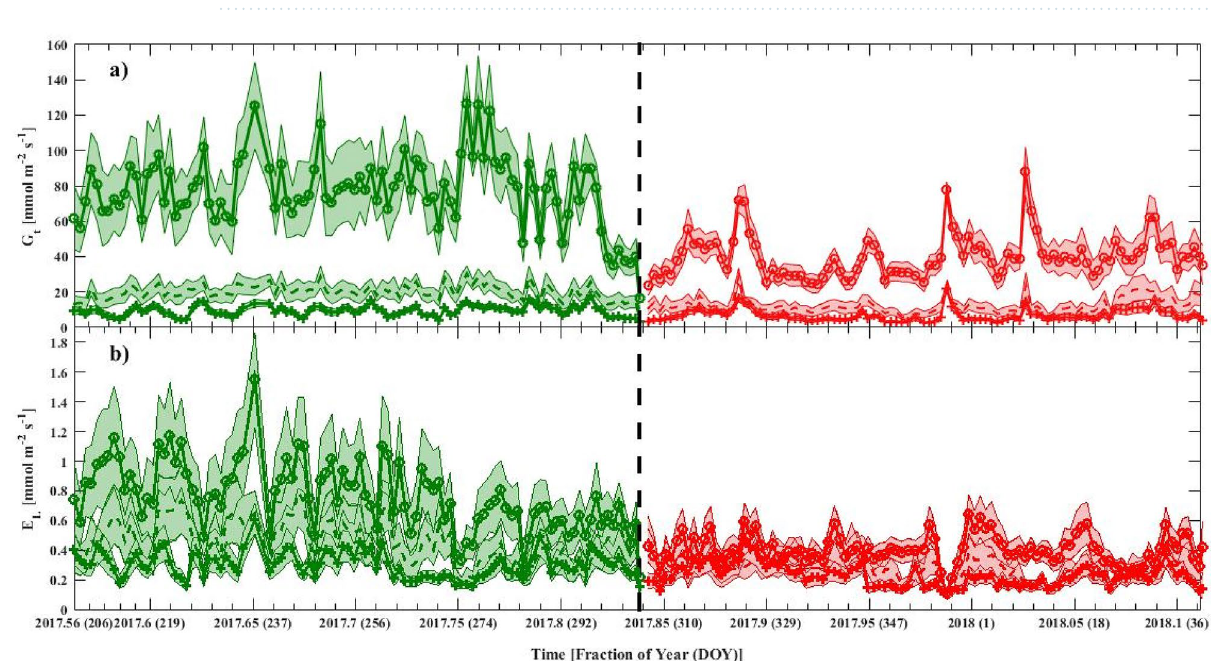
indicated in Table 2, whole-tree canopy conductance varied the greatest in L. speciosa with the relative sensitivity to natural log of VPD being low (λ/ G ref < 0.50) during both seasons for all the species, with only exception being P. indicus during the dry season (λ/ G ref > 0.70). Both G t and E L showed similar seasonal variation for a given species but with varying intensity (Fig. 2). The uncertainty in daily G t and E L averages was high during the wet season, indicating that the variability in VPD and soil moisture contributed greatly, relative to the model error. Such errors can be amplified further at much shorter, half-hourly timescale, as indicated by the variable R 2 for the three species (Fig. 1). Overall, the mean values of both G t and E L were statistically different among species and between seasons. L. speciosa had the highest G t and E L while P. indicus had the lowest values. Both G t and E L were significantly higher in wet season than in dry season. This difference was more pronounced in G t , where, for L. speciosa , it was about 10 times higher than P. indicus, while E L was approximately 2 times higher. However, only the mean daily values indicated a significant interaction between species and seasons. This may be attributed to the lower